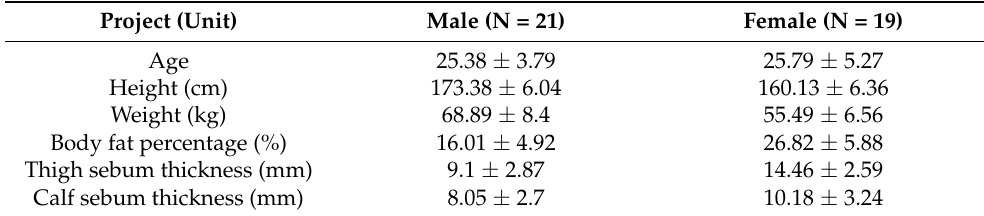
Table 2. The subjects’ basic information, body composition, and thicknesses of thigh and calf